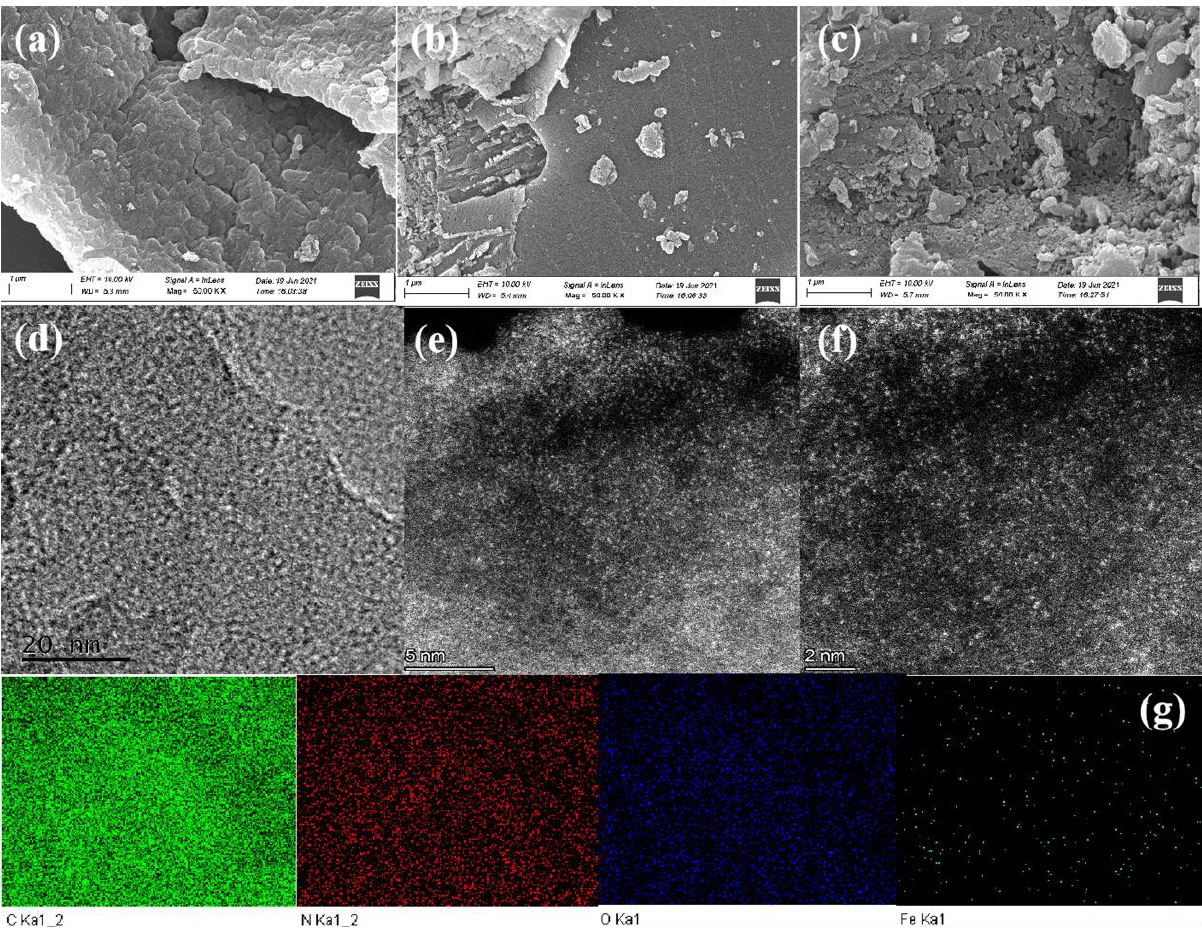
Figure 1. SEM images of g-C 3 N 4 ( a ) Fe(acac) 3 /g-C 3 N 4 ( b ), and Fe-SACs/g-C 3 N 4 ( c ); TEM image of Fe- SACs/g-C 3 N 4 ( d ); HAADF-STEM images of Fe-SACs/g-C 3 N 4 ( e – f ); and the corresponding element mappings for the C (Green), N (Red), O (Blue) and Fe (cyan-blue) atoms of Fe-SACs/g-C 3 N 4 ( g ).